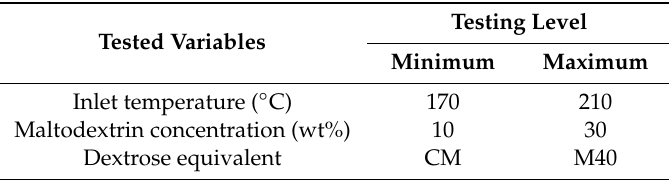
Table 1. Testing levels of variables in D-optimal experimental